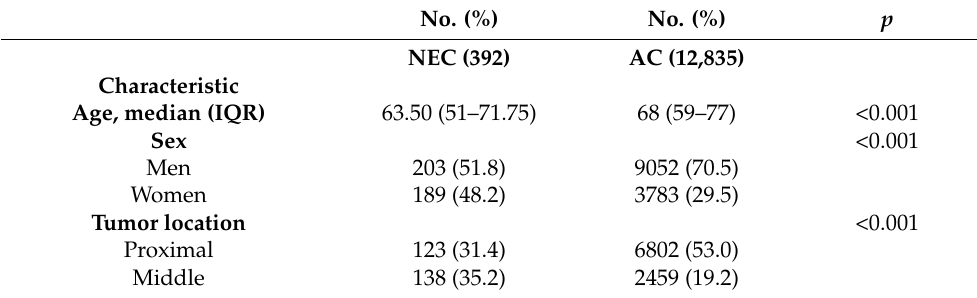
Table 1. Baseline Clinicopathologic Characteristics of White Patients with Gastric Neuroendocrine Carcinoma and Adenocarcinoma in the Unmatched